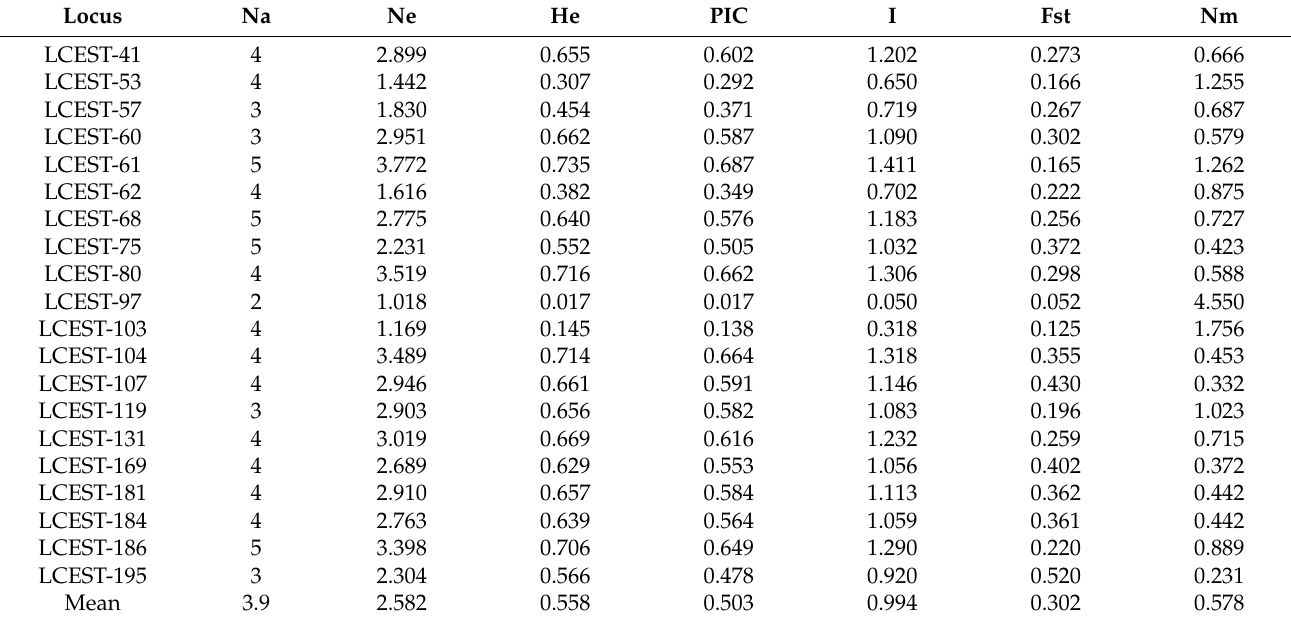
Table 1. Polymorphism information for 20 microsatellite loci amplified in L. chinense .